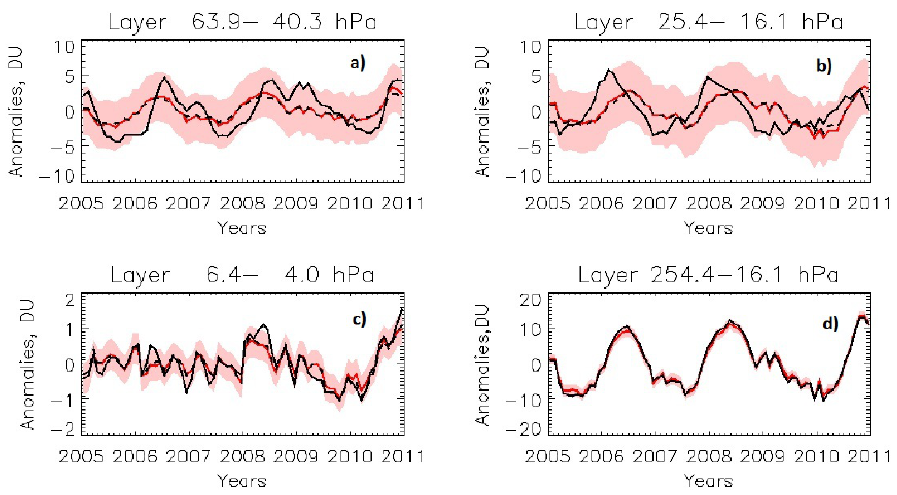
Fig. 8. Time series of the deseasonalized ozone anomalies obtained from SBUV and Aura MLS for several layers in the tropical stratosphere: (a) 63–40hPa layer; (b) 25–16hPa layer; (c) 6–4hPa layer; and (d) 254–16hPa layer. Red lines show SBUV anomalies along with the corresponding smoothing errors (shadowed pink areas indicate ± 2 σ range). Black lines show MLS anomalies, and black dashed lines indicate convolved MLS anomalies. The 254–16hPa ozone columns (for both SBUV and MLS) were calculated by simply summing partial ozone columns in six individual layers (layers